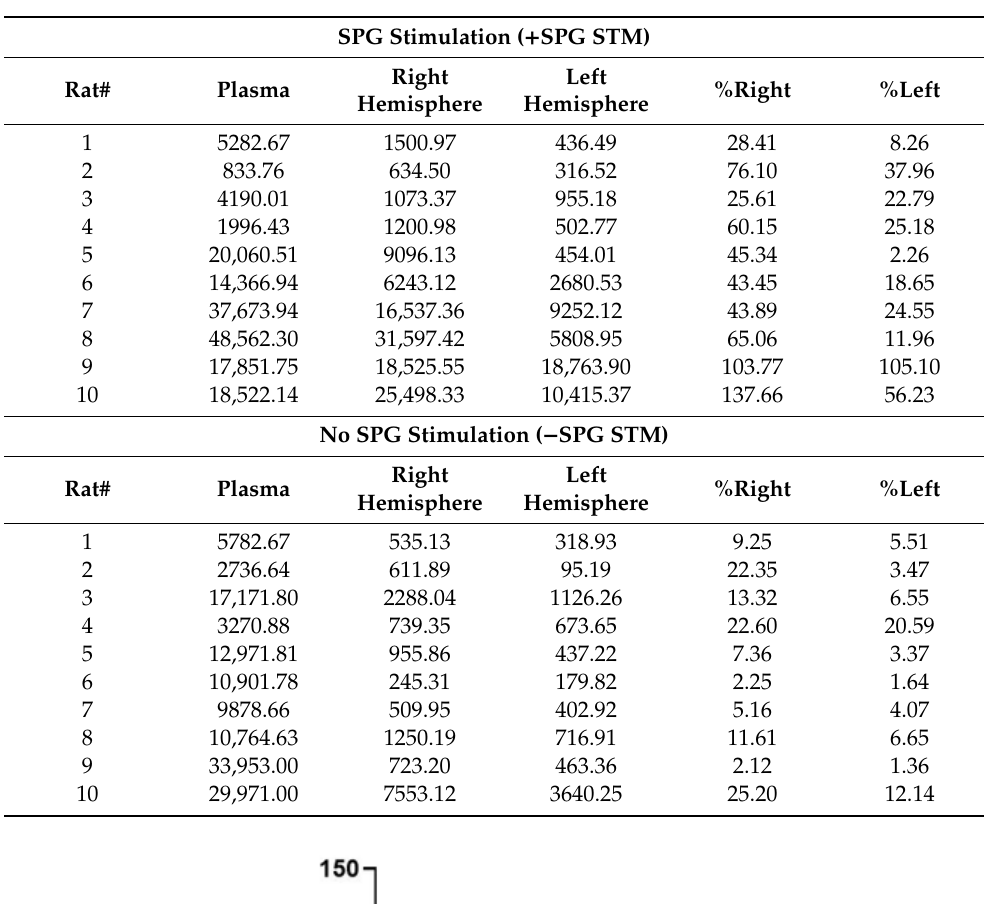
Table 3. TMZ in brain and plasma concentrations (all units are expressed in ng / mL) and respective percentage of permeability of drug in the right and left hemispheres of brain of rats. TMZ was administered intra-arterially, 50 mg / kg bw of rats. Rat brain tissue were harvested 30 min after the drug administration and SPG stimulation (if applicable).